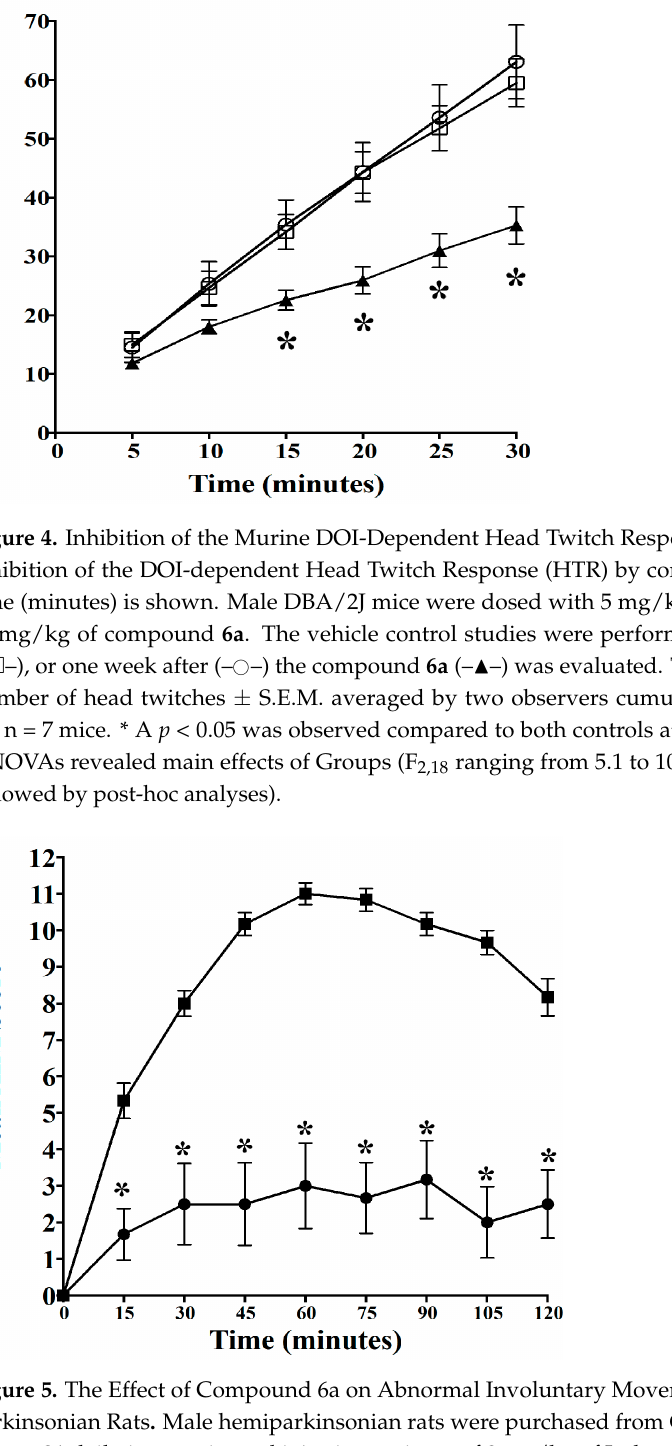
Group (F 1,10 = 26.98; p < 0.001), a main effect of Time (F 7,70 = 15.61; p < 0.001) and an interac- tion between Time and Group (F 7,70 = 7.44; p < 0.001).